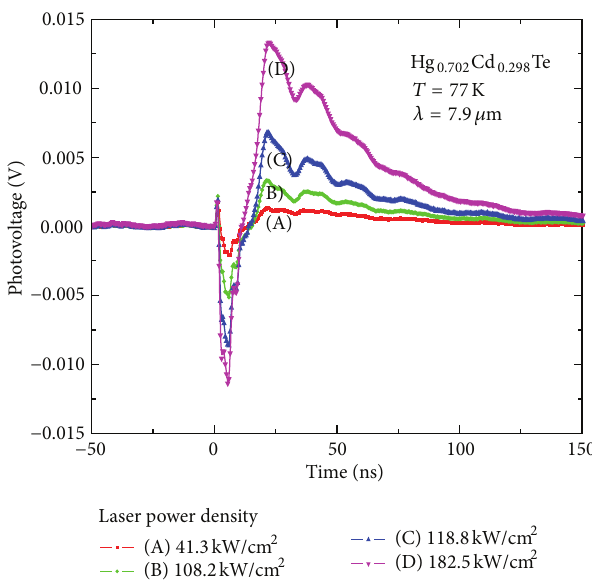
Figure 3: Transient PV response of the detector illuminated by the pulsed laser with the photon energy smaller than the bandgap for the different incident